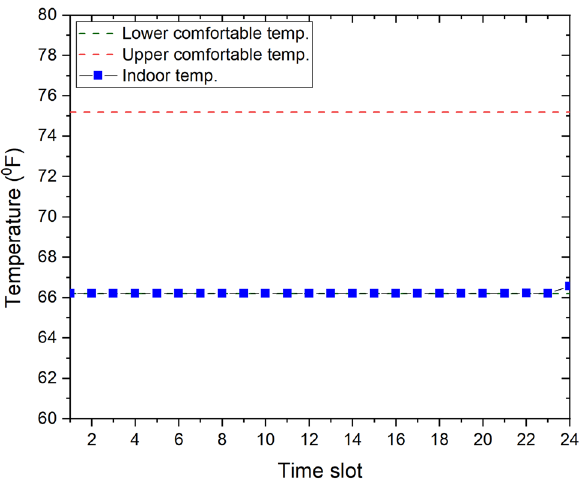
Figure 7. Indoor temperature during day at every home of community with thee CEMSs.